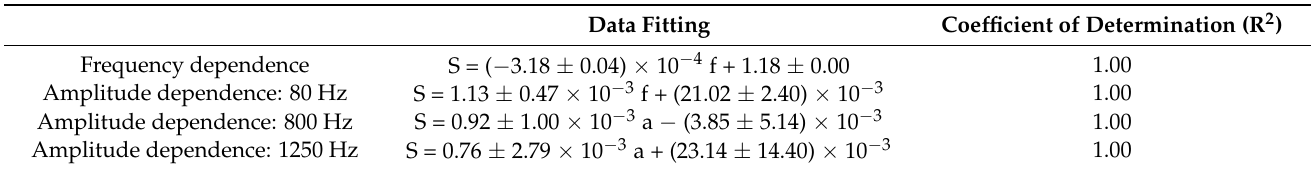
Table 4. Fitting parameters for the frequency and amplitude response of the vibration-sensing E-yarn embedded into fabric. S is the sensor response, f is the frequency, a is the